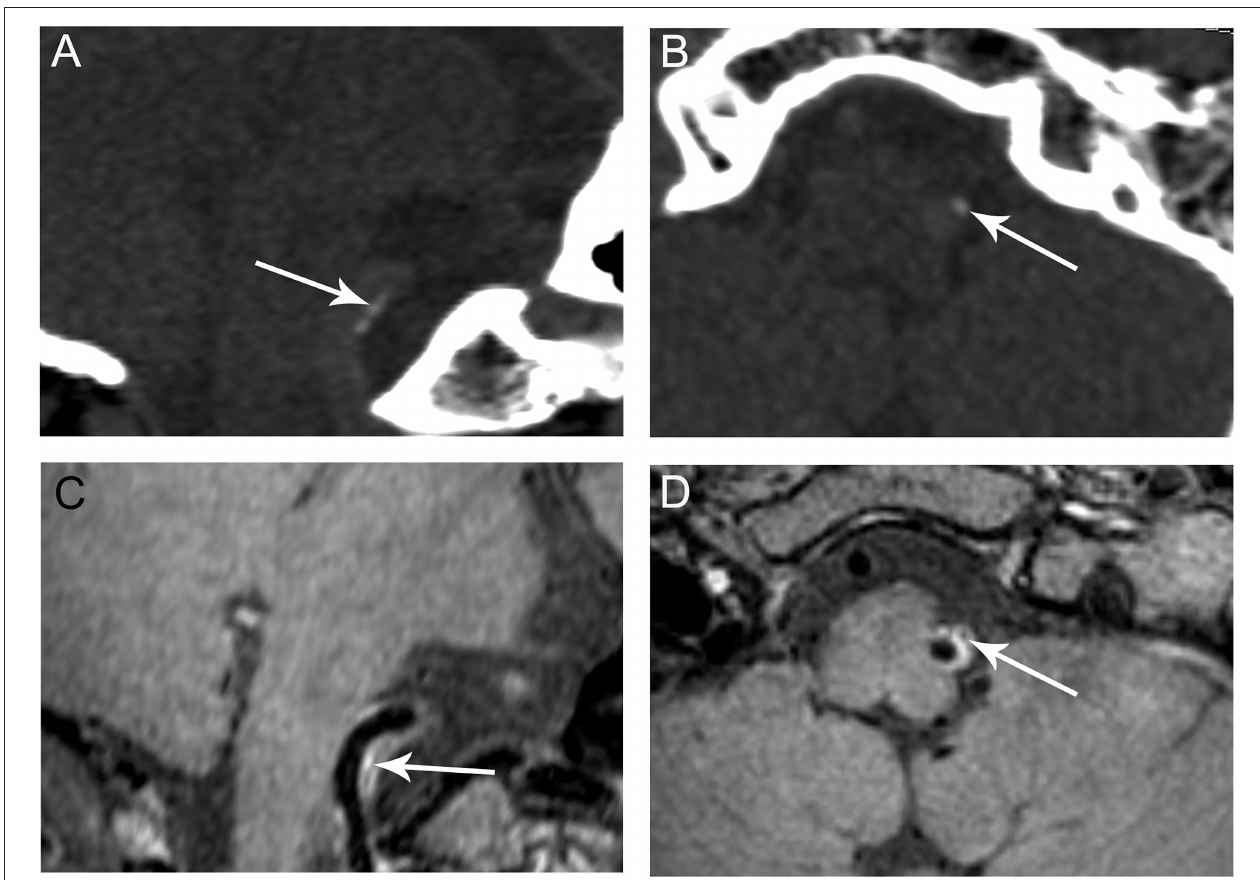
FIGURE 2 | Representative images of predominant intimal VA calcification. CT shows a small clustered calcification on the long ( A , arrow) and short axes ( B , arrow) of the right VA indictive of intimal calcification. The calcification corresponds to a hypointensity area ( C,D , arrows) within an atherosclerotic plaque observed on